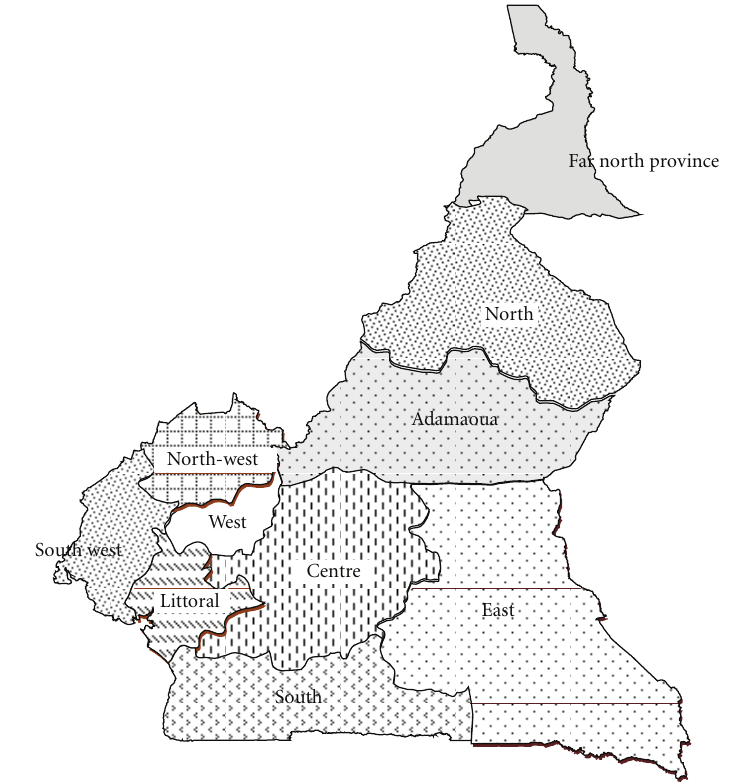
Figure 1: Regional presentation of Cameroon.